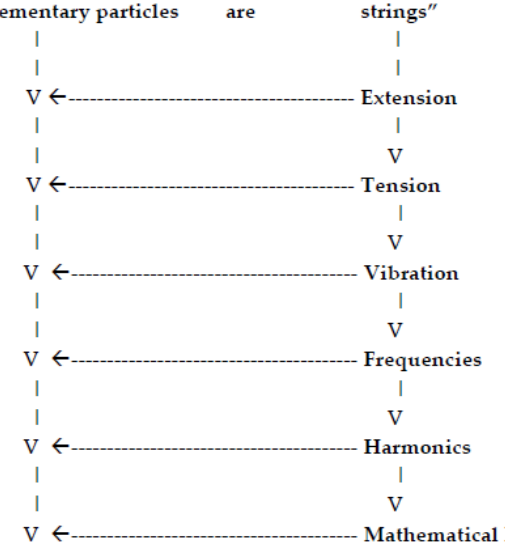
Figure A1. Metaphor Extension in Superstring Theory.